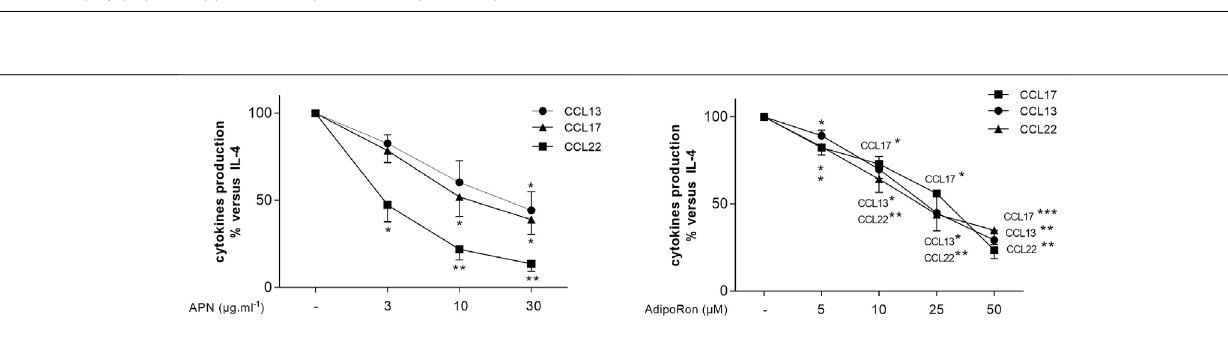
Frontiers in Pharmacology |